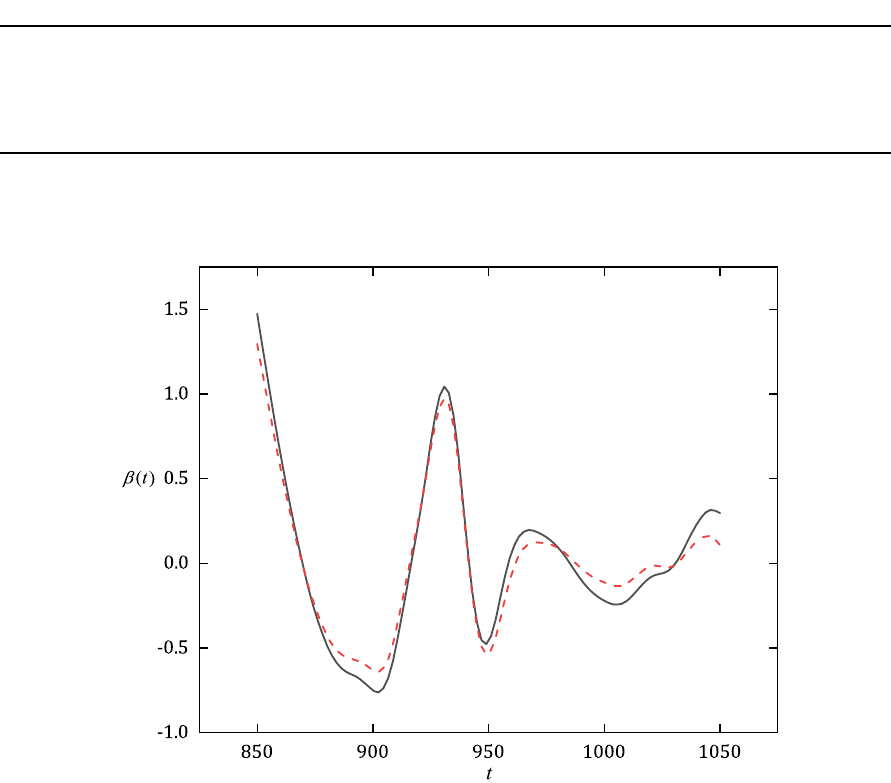
Figure 1: Curves of slope function ( ) β t ˆ with CQR ( solid line ) and WCQR ( dotted line )